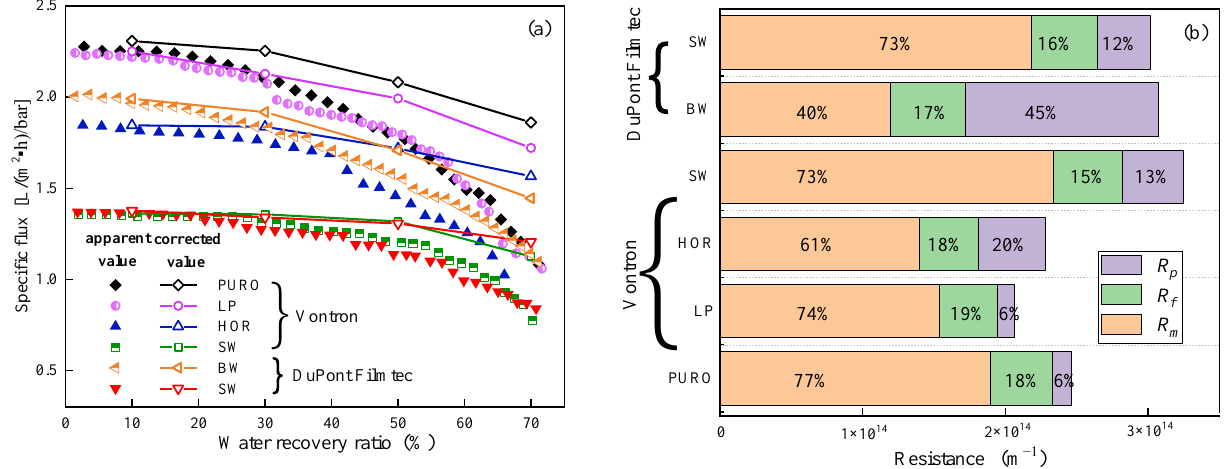
Figure 3. Changes in apparent and corrected specific flux with water recovery ratio ( a ) and resistance composition after filtration ( b ) for each RO membrane.